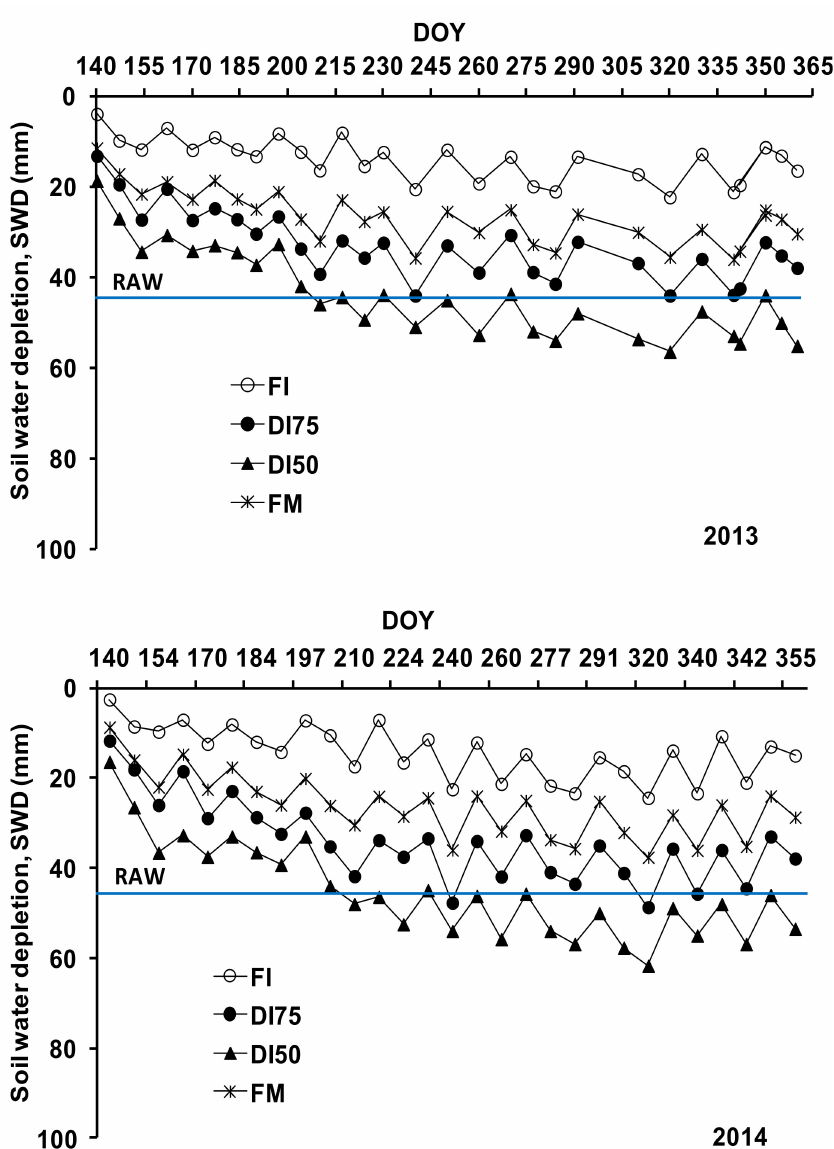
Figure 3. Soil water depletion (SWD, mm) in table olive trees for the 4 irrigation treatments in 2013 and 2014. The irrigation treatments consisted of providing 100% ETc (FI), 75% ETc (DI75), 50% ETc (DI50), and grower’s irrigation program (FM); ETc was estimated by the FAO-56 method; and DOY is the day of year. Blue horizontal line represents the RAW